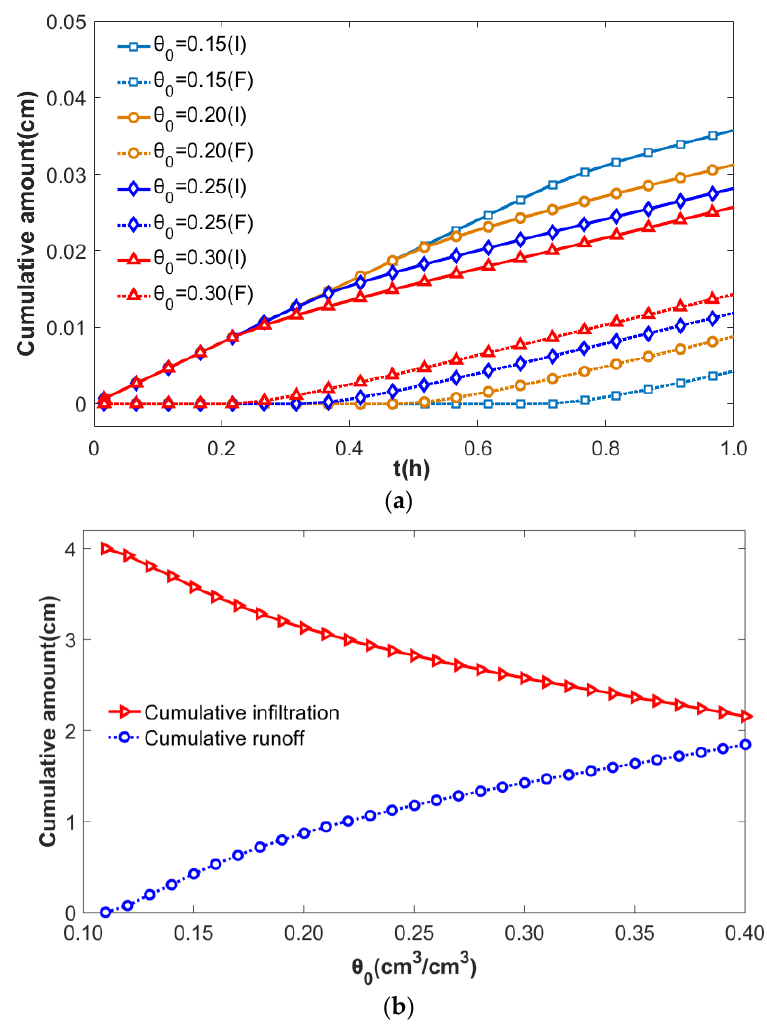
Figure 7. Cumulative infiltration and runoff versus time with different initial soil water contents. ( a ) Cumulative infiltration and cumulative runoff with different initial soil water contents; ( b ) Cumulative amount versus initial soil water contents at t = 1